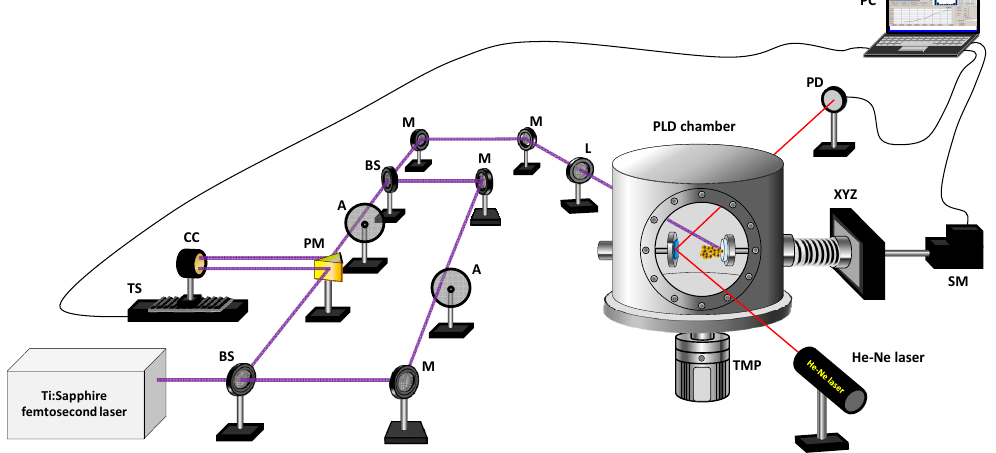
Figure 1. Scheme of the experimental set-up for double pulse femtosecond pulsed laser deposition (PLD). Symbols in the figure correspond to: TS = translation stage, CC = corner cube, BS = beam splitter, PM = prism mirror, M = mirror, A = attenuator, L = focusing lens, TMP = turbomolecular pump, PD = photodiode, XYZ = xyz positioning system, SM = step motor, PC = computer.